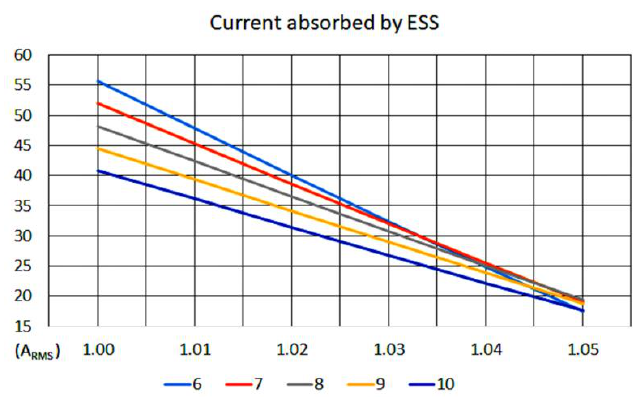
Figure 6. Currents demanded (A RMS ) by ESS under different regulating voltage levels.